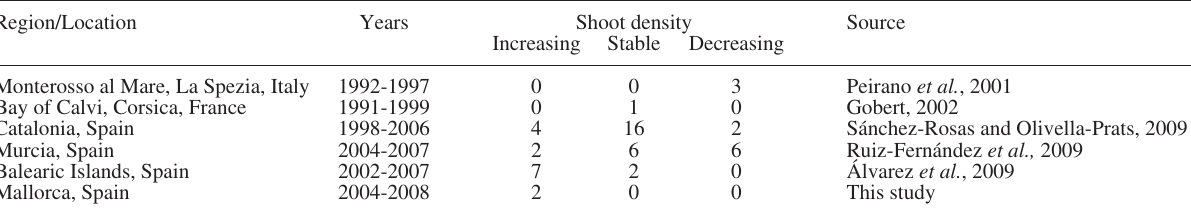
Table 3. – Inter-annual trends of shoot density of Posidonia oceanica meadows in the western Mediterranean. The number of meadows where shoot density was either increasing, stable or decreasing during the years indicated is presented. Only those meadows with a minimum of four years of data within the indicated period are